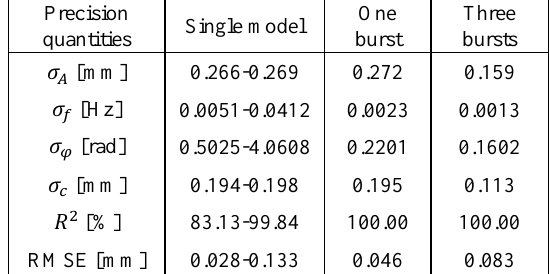
Table 5. Statistical values for the sinusoidal fitting parameters